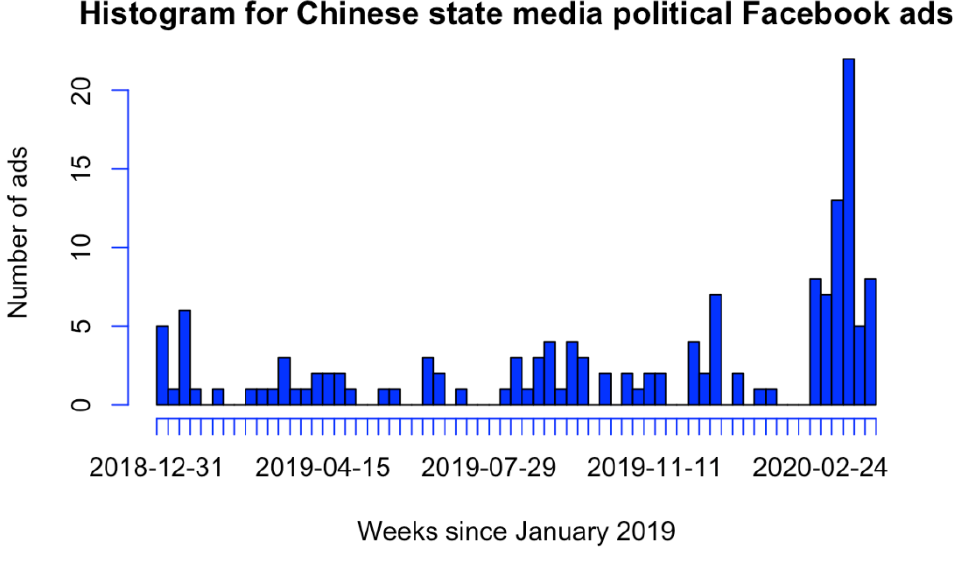
Figure 8 : Histogram showing number of Chinese state media Facebook advertisements per week between January 1, 2019 and March 29, 2020. More than half of all advertisements were created in the period from January 1, 2020 to March 29, 2020, 77 percent of the newer ads mention “coronavirus” or “covid .